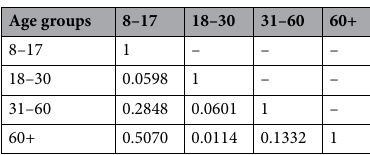
Table 8. P-values based on paired Wilcoxon tests for usability scores from four age groups.